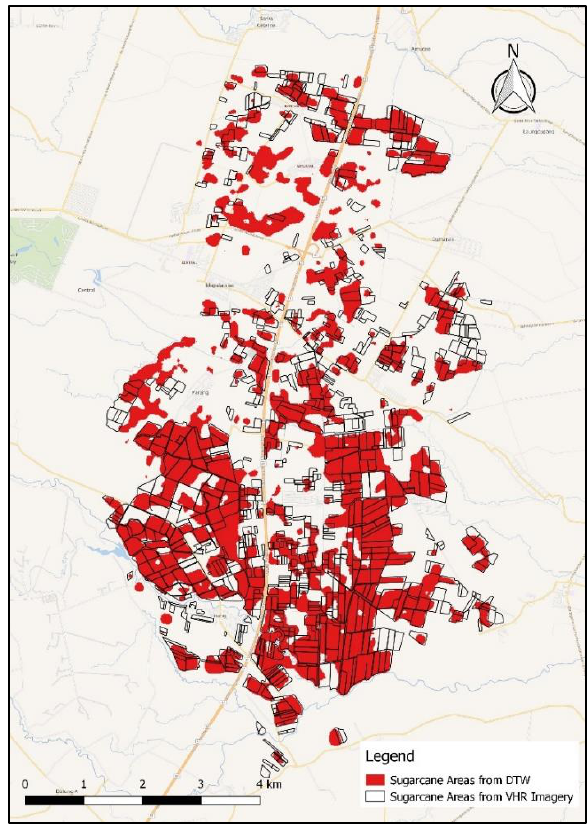
Figure 8. Sugarcane map from DTW